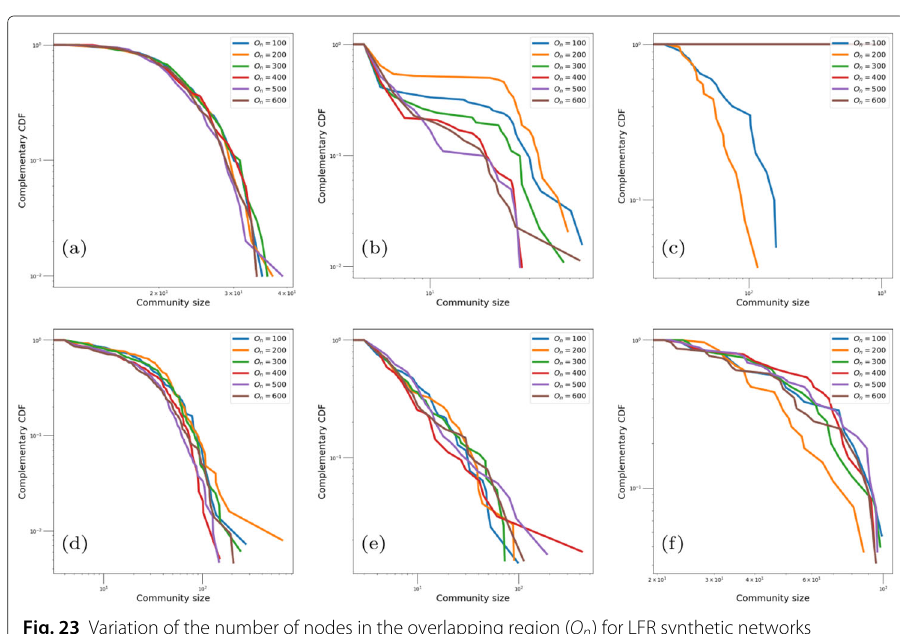
Fig. 23 Variation of the number of nodes in the overlapping region ( O n ) for LFR synthetic networks considering the community size: a Bigclam; b CFinder; c Copra; d Demon; e SLPA; f Ground-Truth